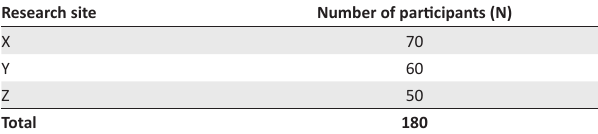
TABLE 1: Number of participants per research site. Research